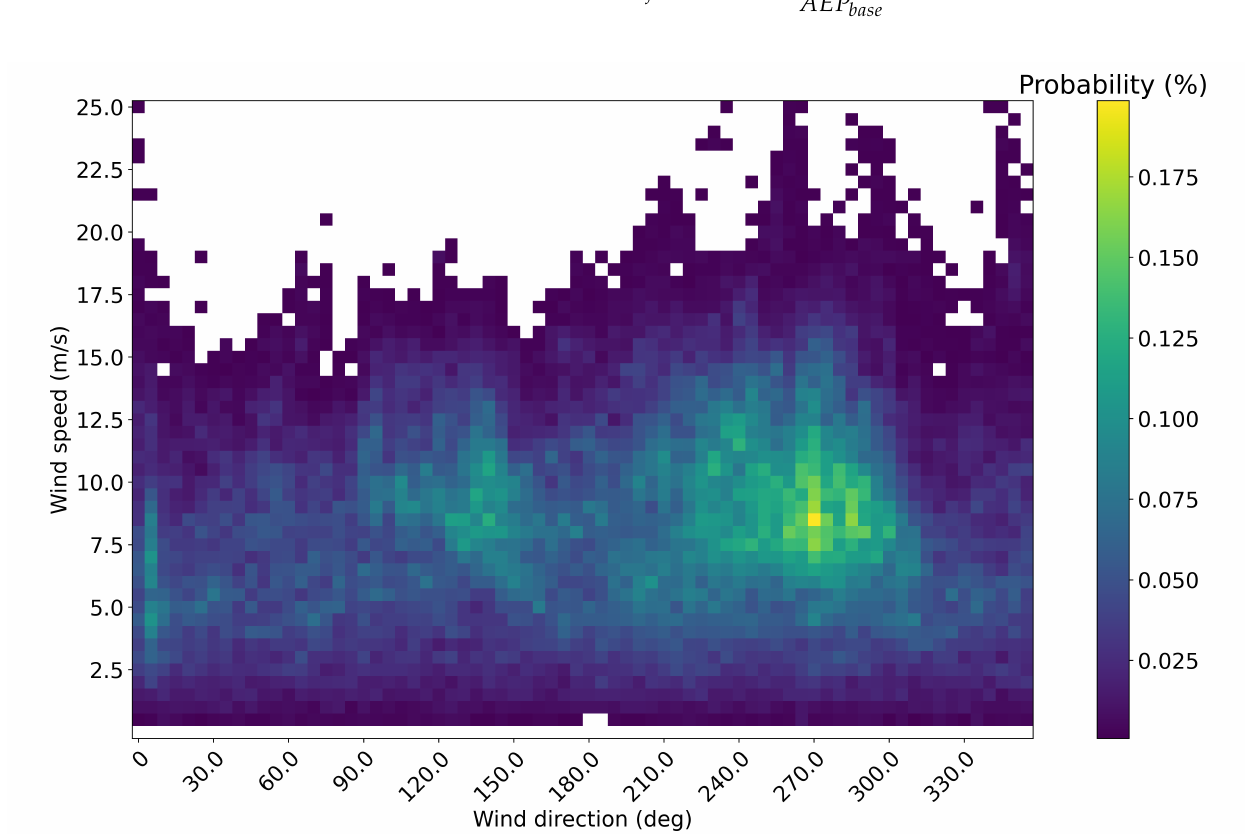
Figure 3. Joint probability of the freestream wind speed U ∞ and wind direction θ ∞ in